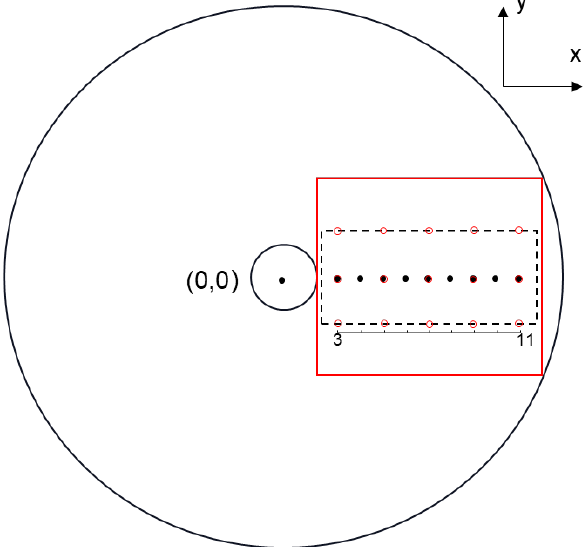
Figure 3. Schematic of numerical simulation. Coordinate axis units are millimeters.